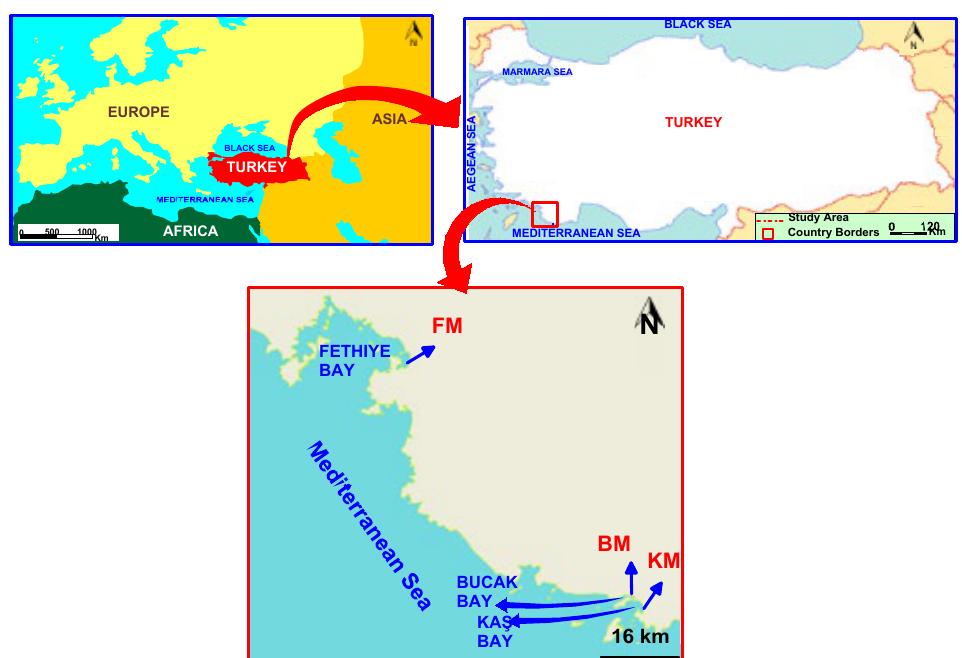
Fig. 1: Geographic location of the study area and measurement stations FM in Fethiye Bay, BM in Bucak Bay and KM in Kaş Bay at the south western Mediterranean coast of Turkey Table 1: Water depths and coordinates of sampling points (Hapoğlu et al., 2018; Yıldırım and Balas, 2019) Station